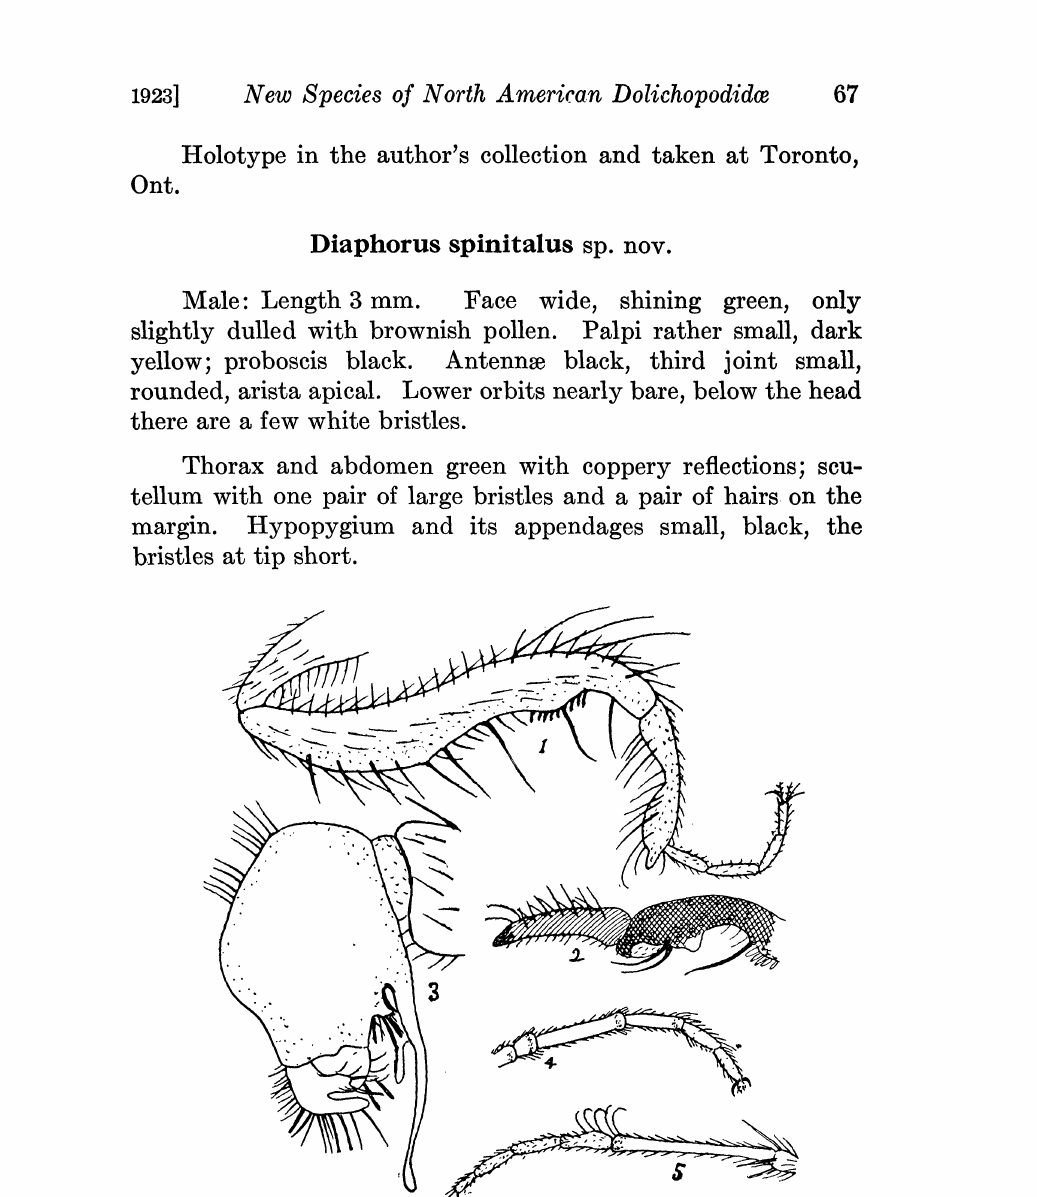
Fig. 1, Carapsicnemus wheeleri sp. nov., middle tibia and tarsus; fig. 2, tip of middle tibia and basitarsus of the same, viewed from the side; fig. 3, Hercostomus costalis sp. nov., hypo- pygium; fig. 4, Nothosympycnus luteipes sp. nov., fore tarsus" fig. 5, middle tarsusof the